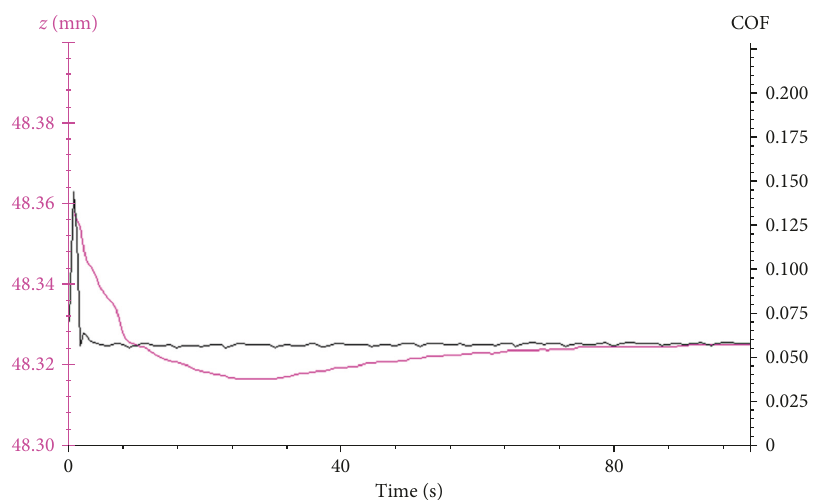
Figure 13: Enlarged view of the first 100 seconds (2Hz, 3N, and albumin solution).